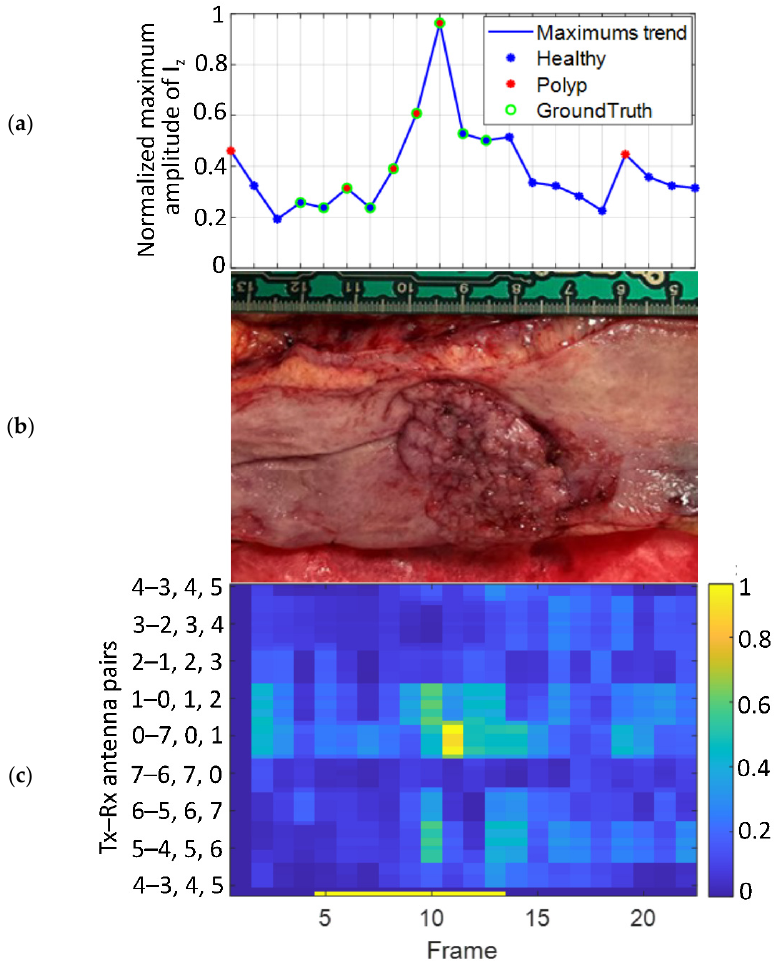
Figure 7. Results of Patient 4. ( a ) The evolution of the normalized maximum amplitude of the reconstructed image for each frame of the trajectory, ( b ) photograph of the colon sample with an adenoma with HGD, ( c ) normalized maximum amplitude in front of all the antenna combinations.